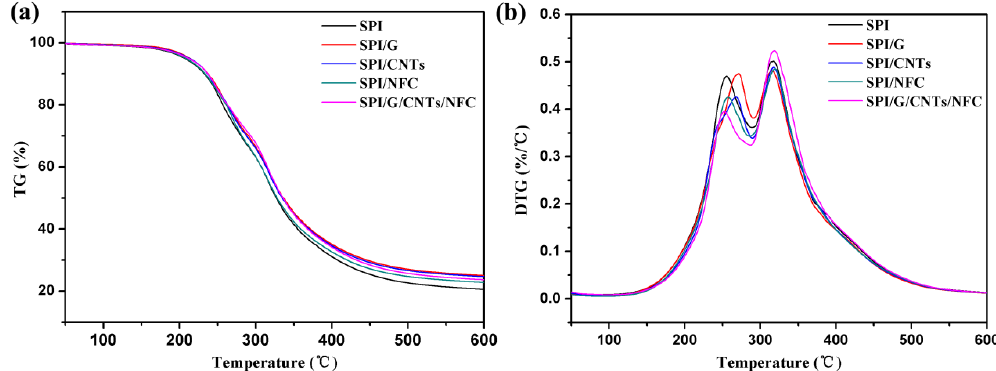
Figure 8. ( a ) Thermogravimetric analysis (TGA) and ( b ) differential thermogravimetry (DTG) curves of SPI, SPI/G, SPI/CNT, SPI/NFC, and SPI/G/CNT/NFC series films. Table 4. The TGA data of SPI, SPI/G, SPI/CNT, SPI/NFC, and SPI/G/CNT/NFC nanocomposite films.